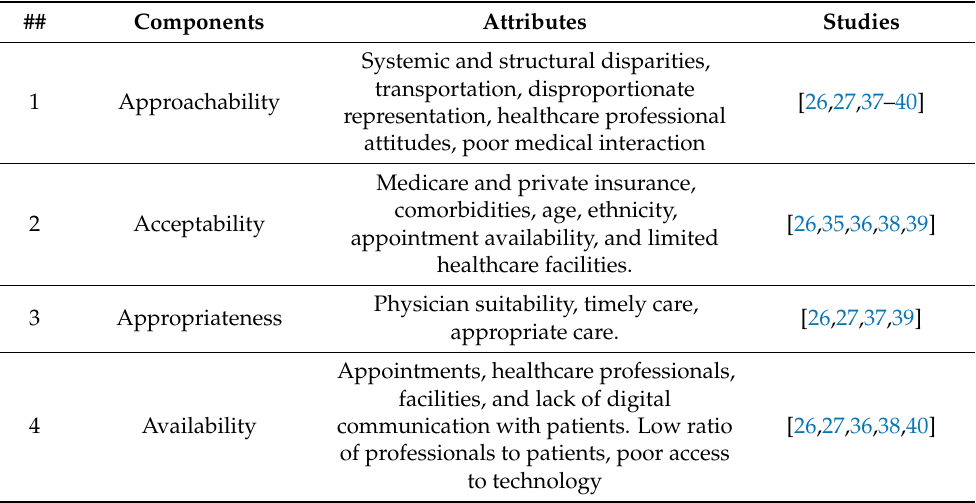
Table 3. Summary of evidence of issues with healthcare accessibility among older African American adults with dementia and COVID-19.